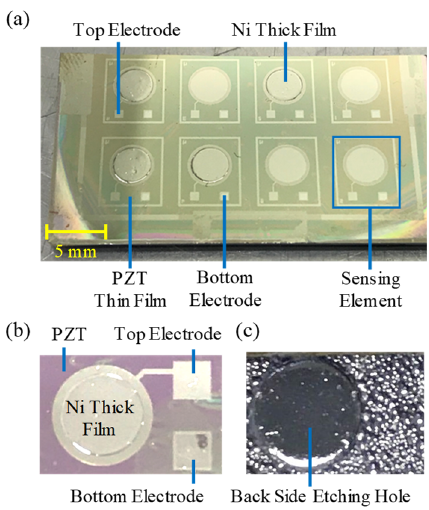
Figure 4. The fabrication results: ( a ) the photograph of the sensors, ( b ) front-side view, and ( c ) back-side view of the enlarged photographs of the sensor.